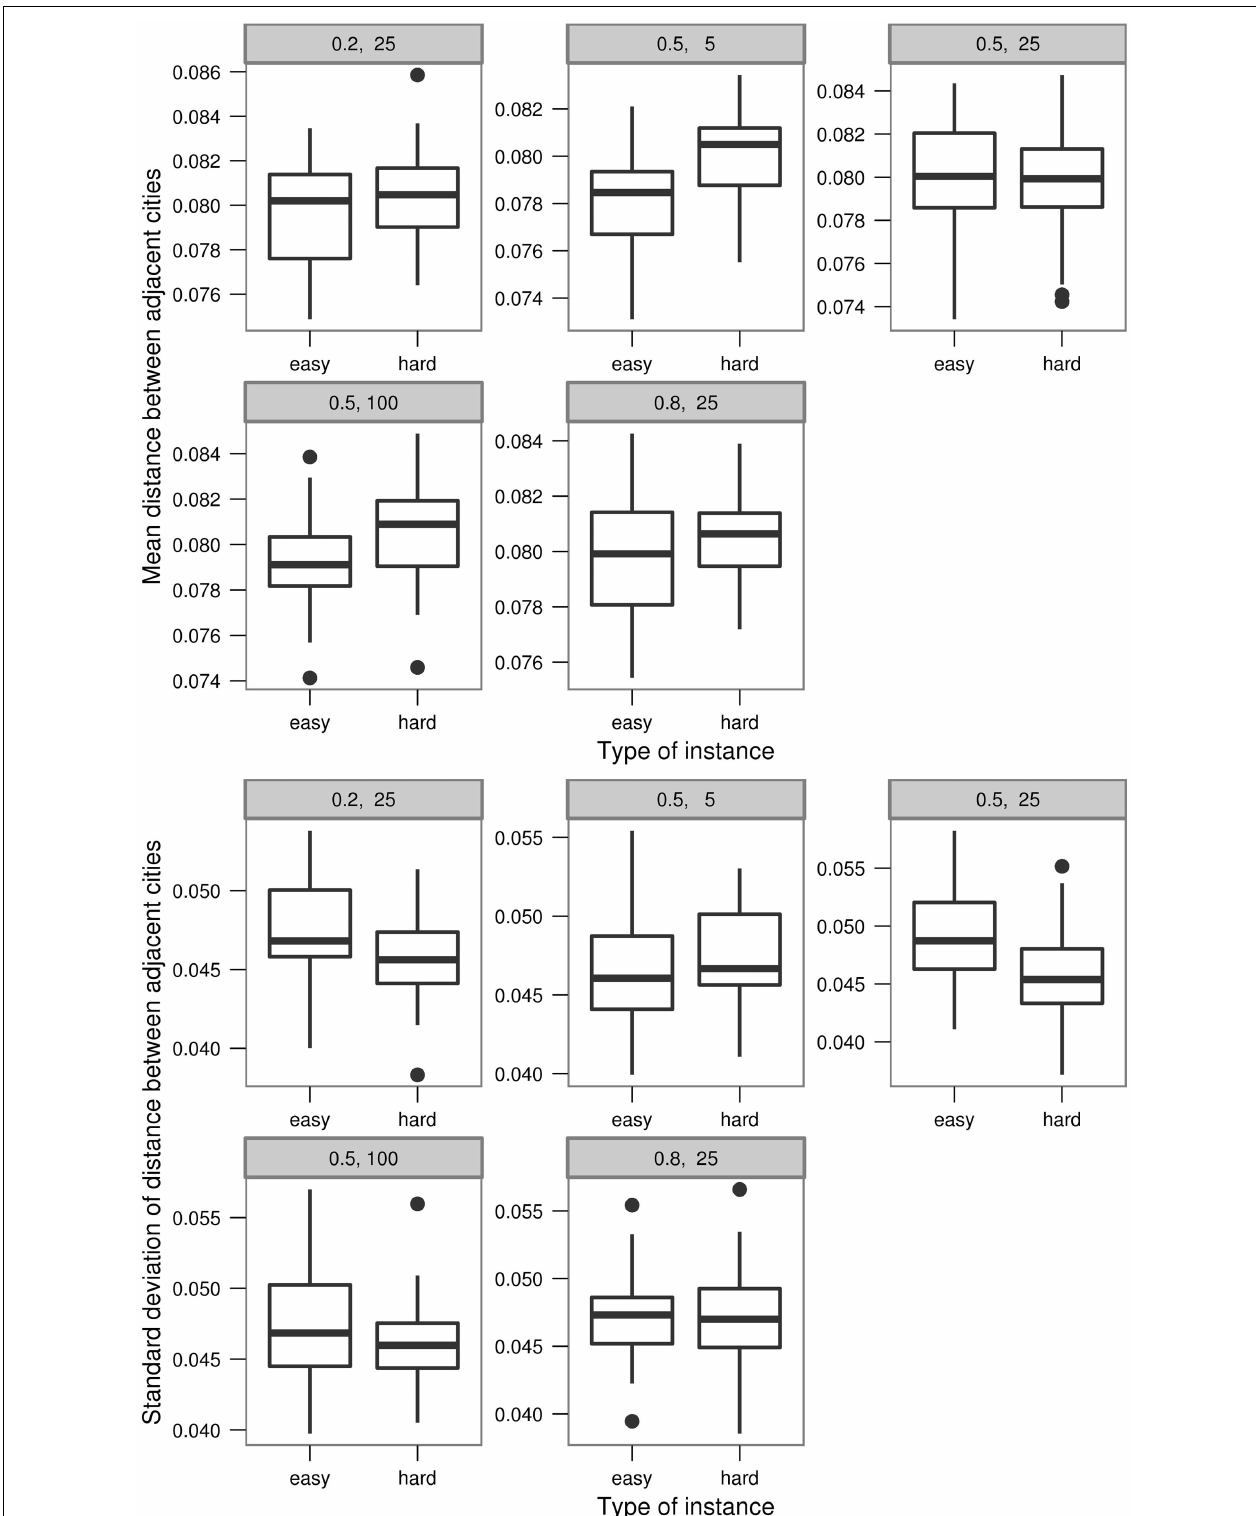
FIGURE 9 | Boxplots of the means (top) and the SDs (bottom) of the distances .